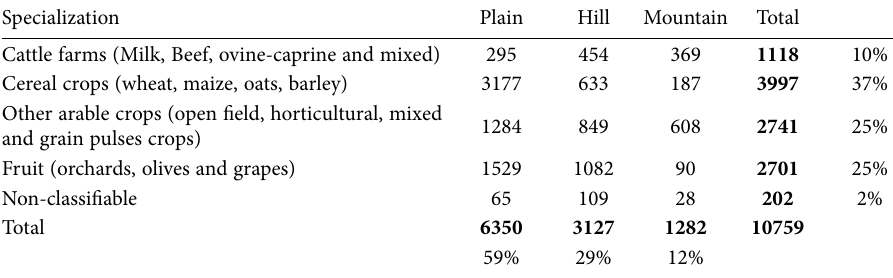
Table 1. Agricultural census data per specialization (type of farming) and altitude